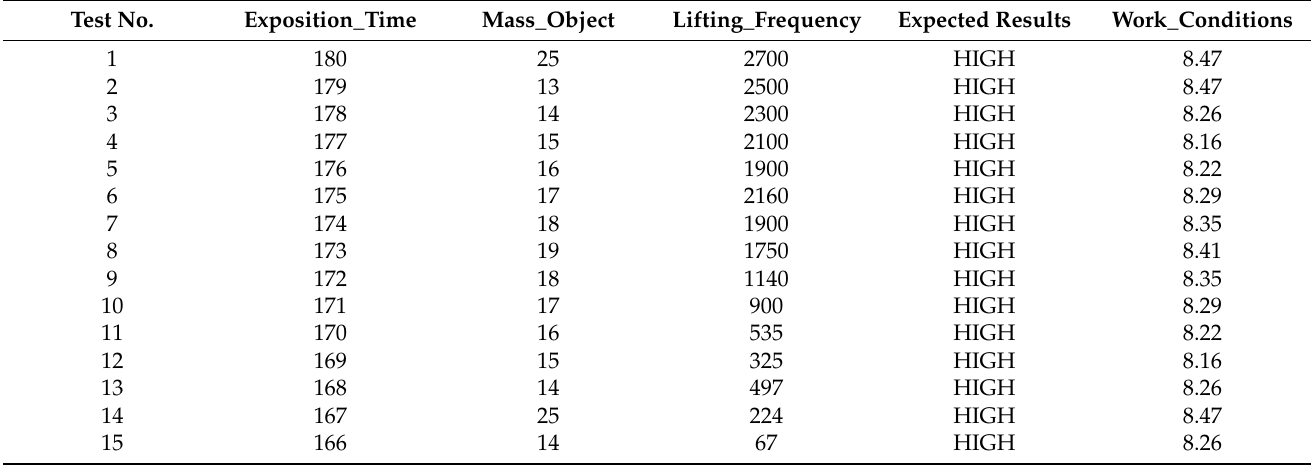
Table A1. Results of comparison between direct assessment (Expected_results) and Fuzzy Ergonomic Assessment